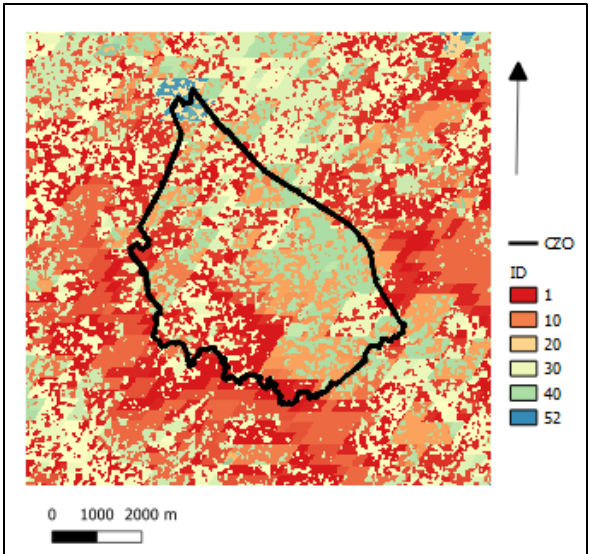
Figure 5.2. Threshold Value =